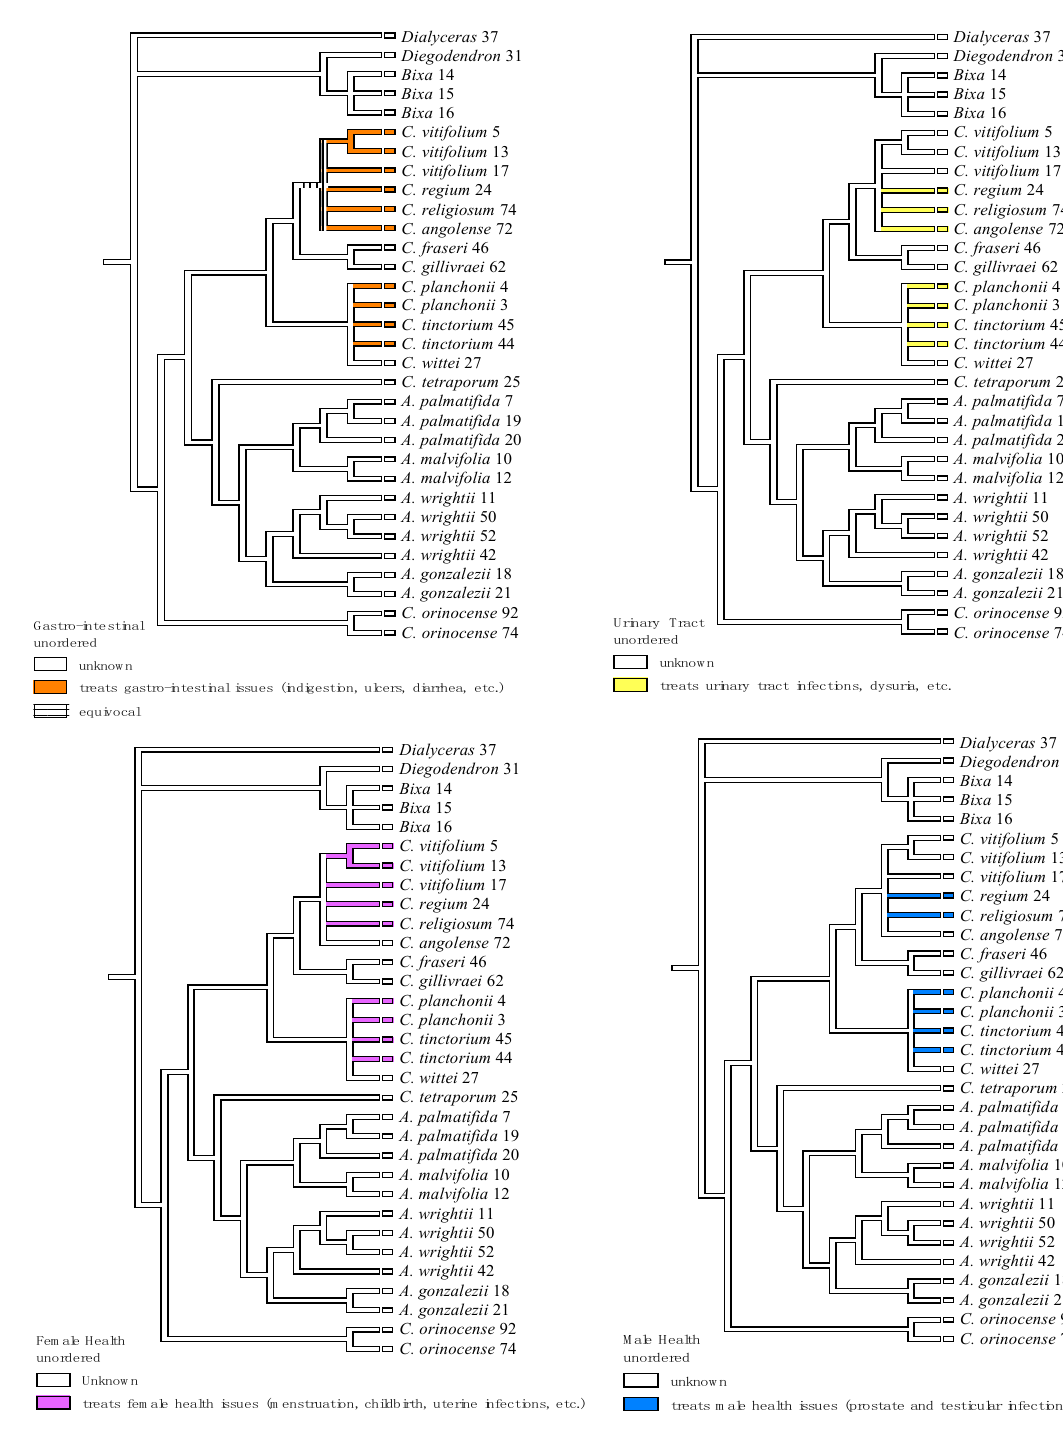
Figure 9. Medicinal uses (treatments for gastro-intestinal, urinary tract, female health, and male health issues) shared by two or more species mapped (as unordered character states) onto the Bayesian inference phylogeny of Cochlospermaceae of the combined nuclear (ITS) and plastid ( trnG and trnL-F ) regions from Johnson-Fulton and Watson [35].